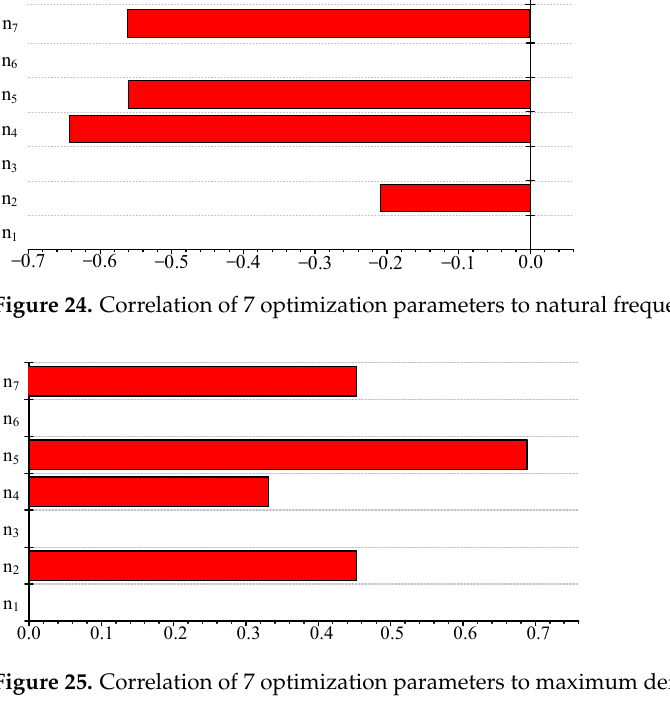
Figure 26. Correlation of 7 optimization parameters to total mass sensitivity. 3.4.2. Response Surface Fitting Results and Discussion The response surface curves are shown in Figures 27–29: